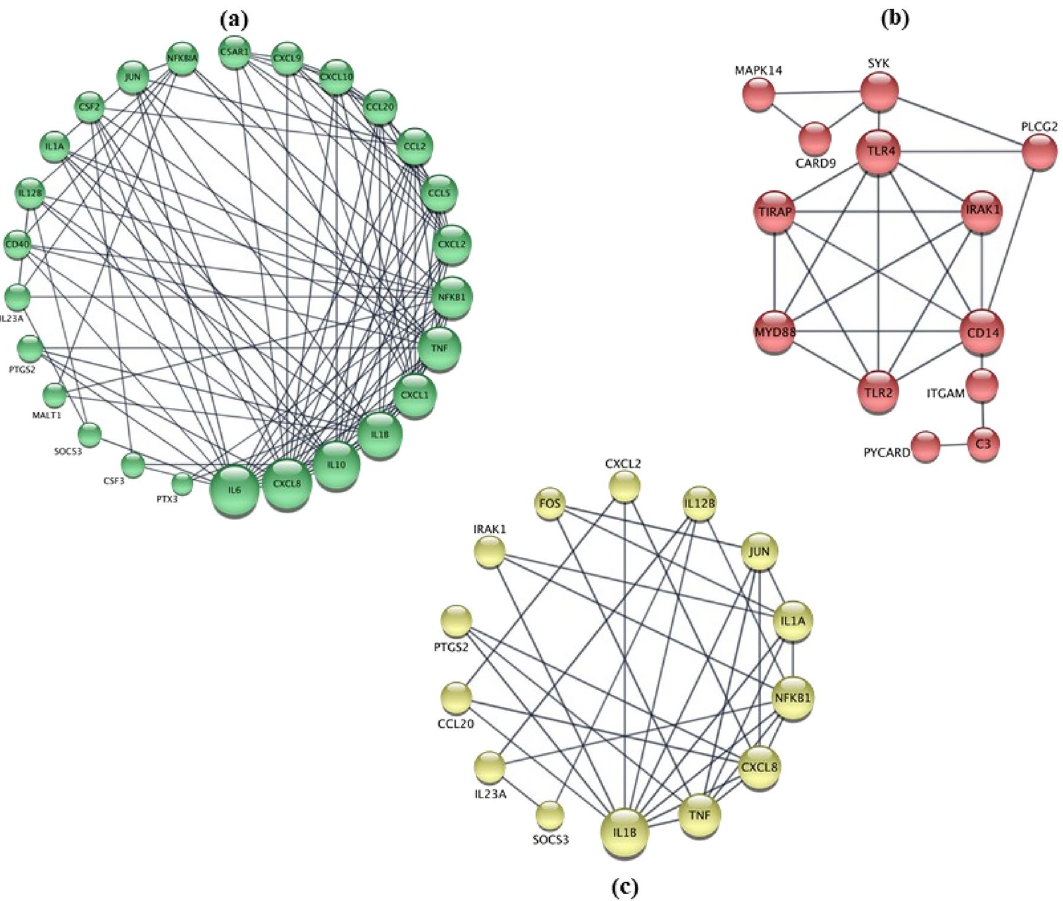
Figure 3. Protein–protein interation (PPI) networks of: ( A ) genes up-regulated by infection, ( B ) genes down- regulated by infection and ( C ) genes up-regulated by infection but also downregulated by applying 1.0 mg/l of AmphoB L (“THP1 AF AL1” column in Fig.